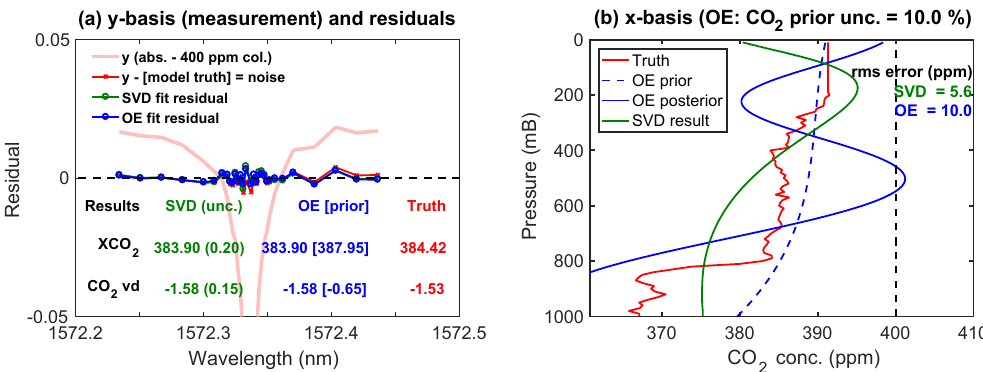
Figure 9. Sample simulated measurement of vertical dipole moment using the SVD method and appropriate constraint. (a) The SVD and OE approaches demonstrate good convergence, and since the SNR is relatively high, the residuals are small. Results projected to the z column mean (first principal component) and vertical dipole basis show reasonable performance of both techniques for retrieving the X CO 2 moment, with agreement within the expected variance. (b) Both methods detect the overall decrease in the CO 2 concentration at low altitudes. Despite a helpful Bayesian prior, the OE retrieval still differs significantly from the true profile. In addition, despite the CO 2 profile differing significantly from the uninformative prior used in the SVD method, the bias in the retrieved X CO is small and for this instance, likely due 2 to random errors (see Fig. 10 for more precise comparisons using an ensemble of